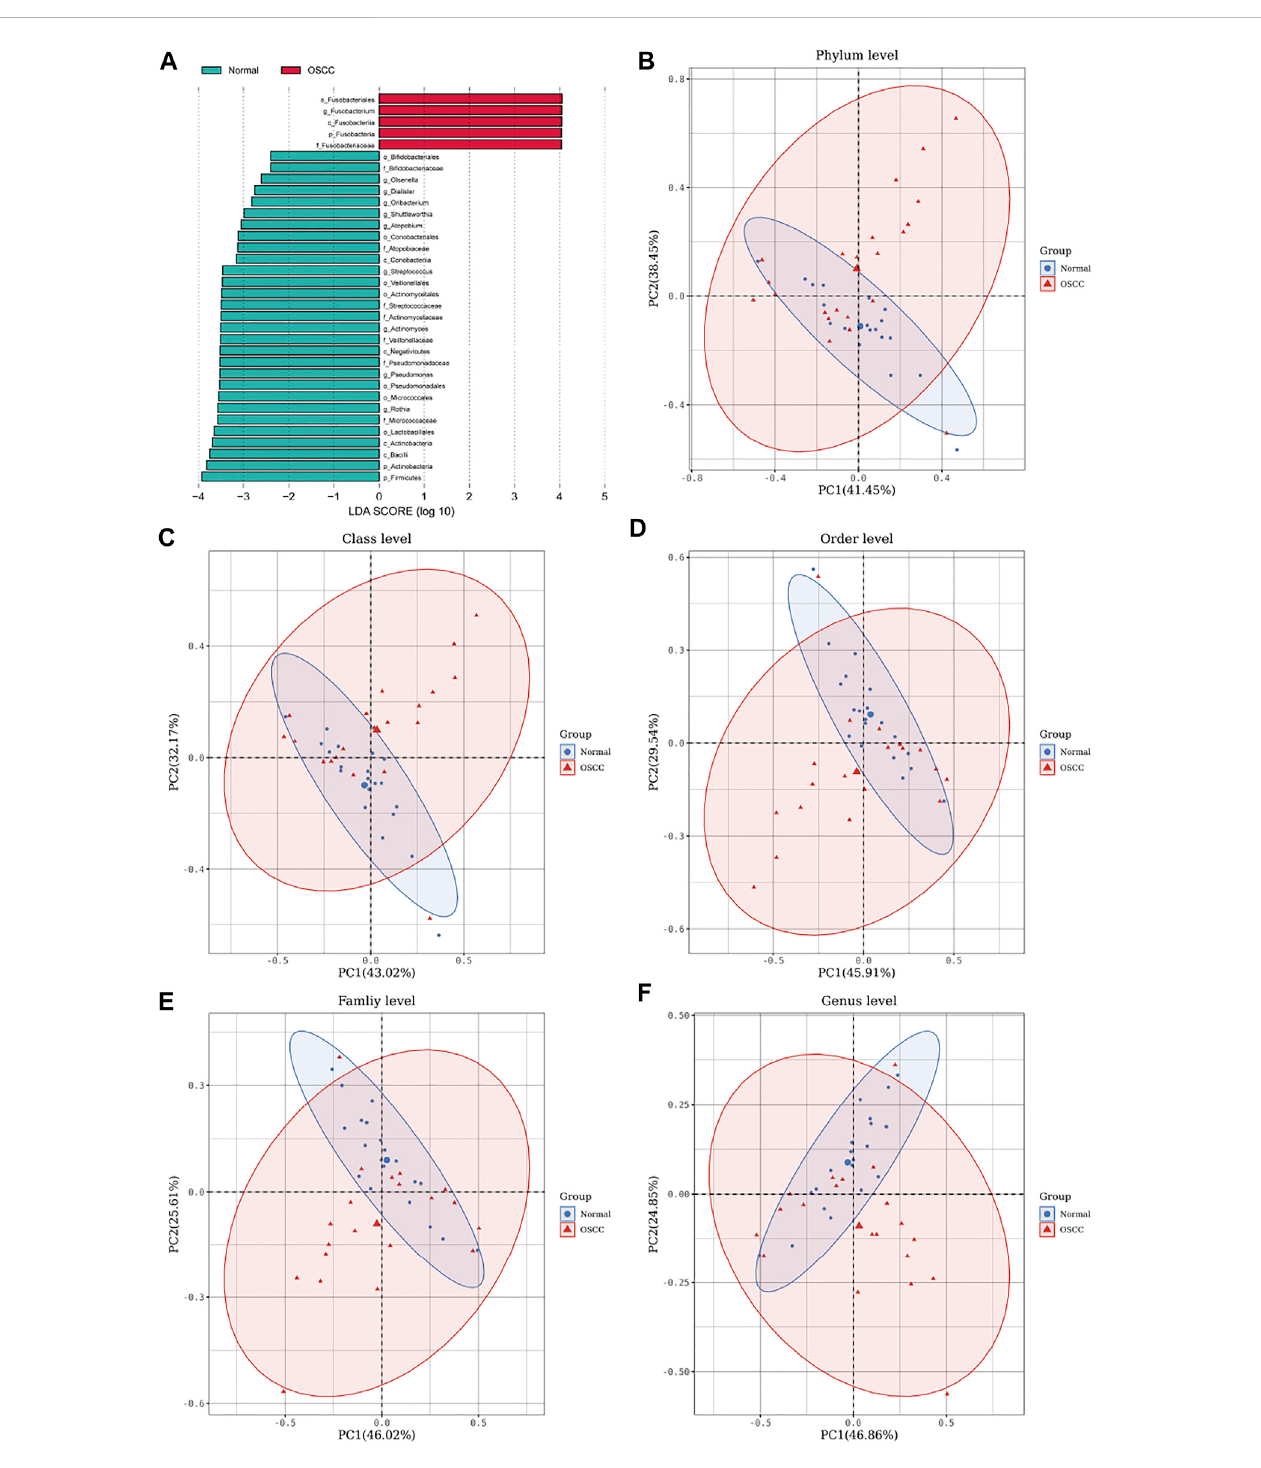
FIGURE 3 LEfSe analyses identifying OSCC and normal tissue-enriched oral microorganisms. (A) . LDA score of speci fi c microbial taxa in the OSCC and normal groups (the threshold LDA score is 2) (B – F) . PCA plots of OSCC and normal tissue samples based on oral microbiota analyses at phylum, class, order, family, and genus levels (one plot characterizes one sample, and the large ellipses in each group represent the 95% con fi dence interval (CI) range of the matching group. Paired samples were selected for this